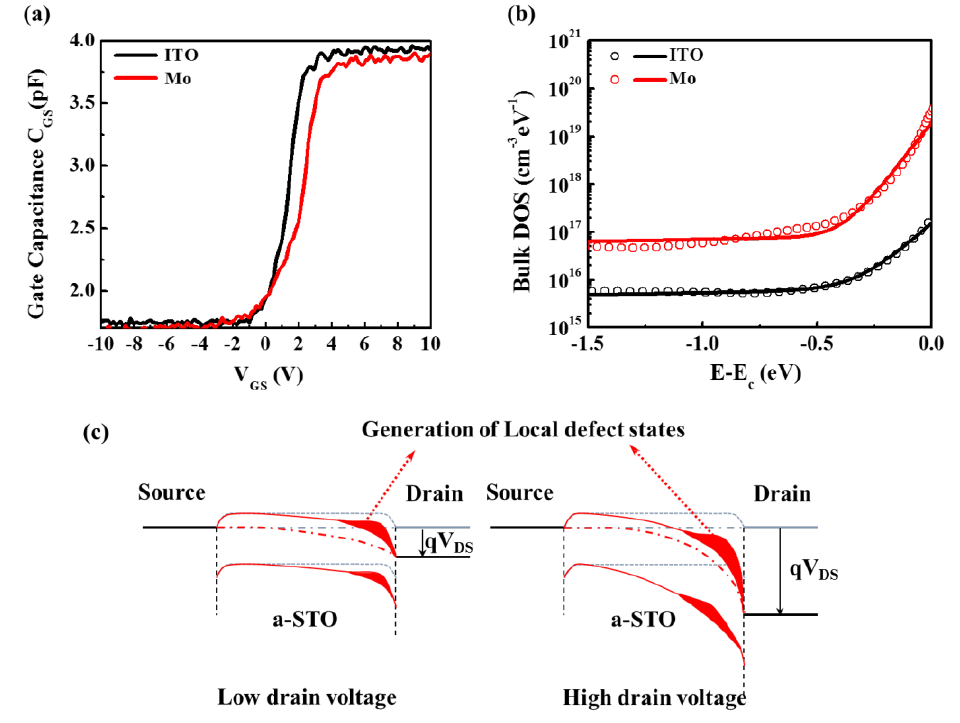
Figure 4. ( a ) Gate capacitance versus gate voltage ( C GS - V GS ) characteristics of a-STO TFTs with different electrodes at 10k Hz. ( b ) Extracted (symbols) and fitted by (5) (solid lines) DOS as a function of E - E C . ( c ) The schematic diagram of local defect states generation. Table 2. The DOS parameters fitted by Equation (5) for different electrodes.